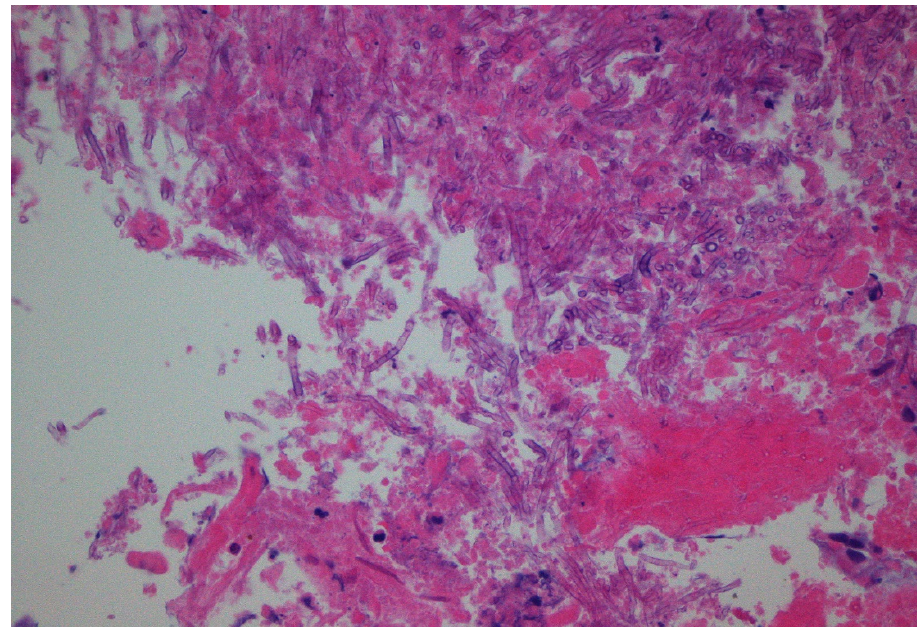
Figure 2. Histopathology of the removed graft revealed regularly septate hyphae branching at 45° angles (hematoxylin and eosin stain, magnification ×40).